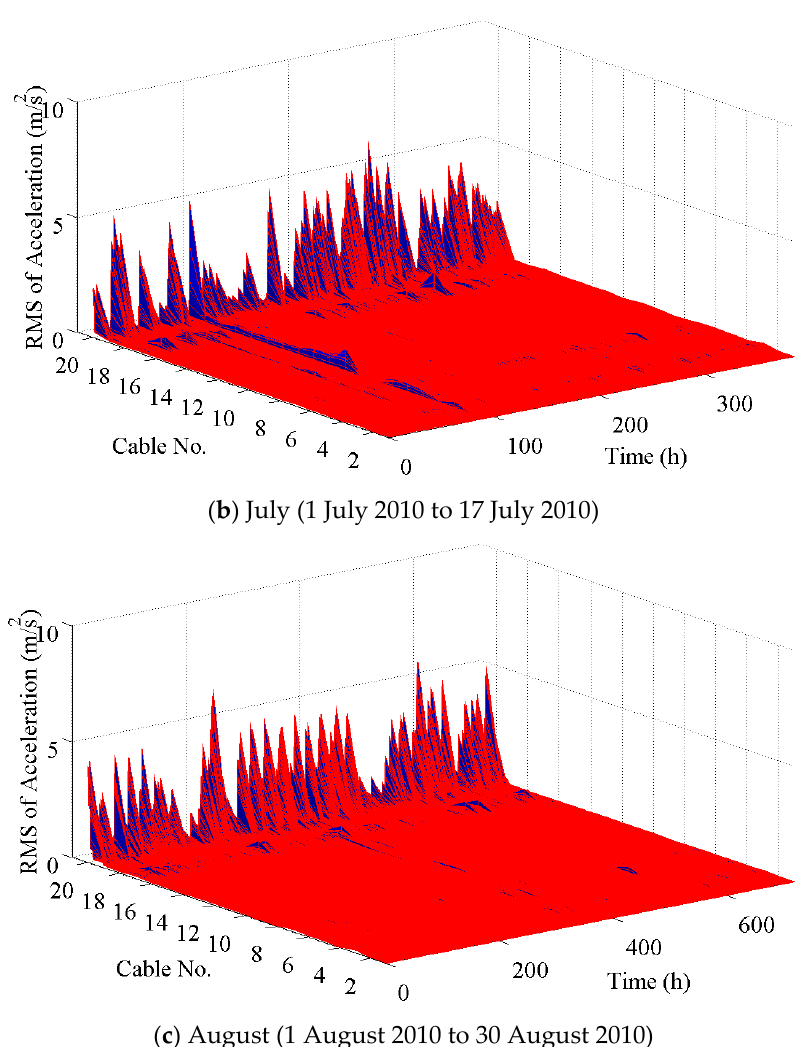
Figure 3. Vibration response of stay cables of the stayed-cable bridge (10 min mean) in 2010.